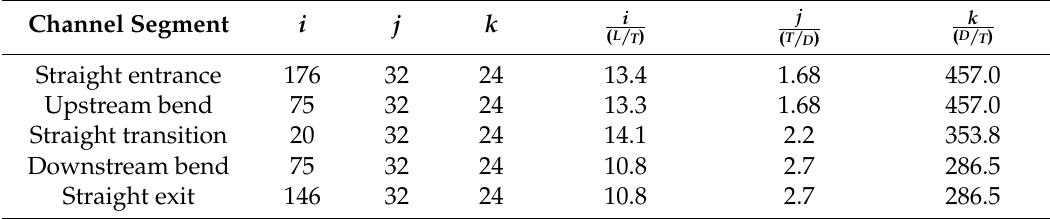
Table 1. Finest numerical model mesh size used to simulate the flow through the CSU physical model ( i , j , and k were the model mesh sizes in the longitudinal, transverse, and vertical dimensions, respectively; L , T , and D were the channel dimensions of length, top width, and depth, respectively).